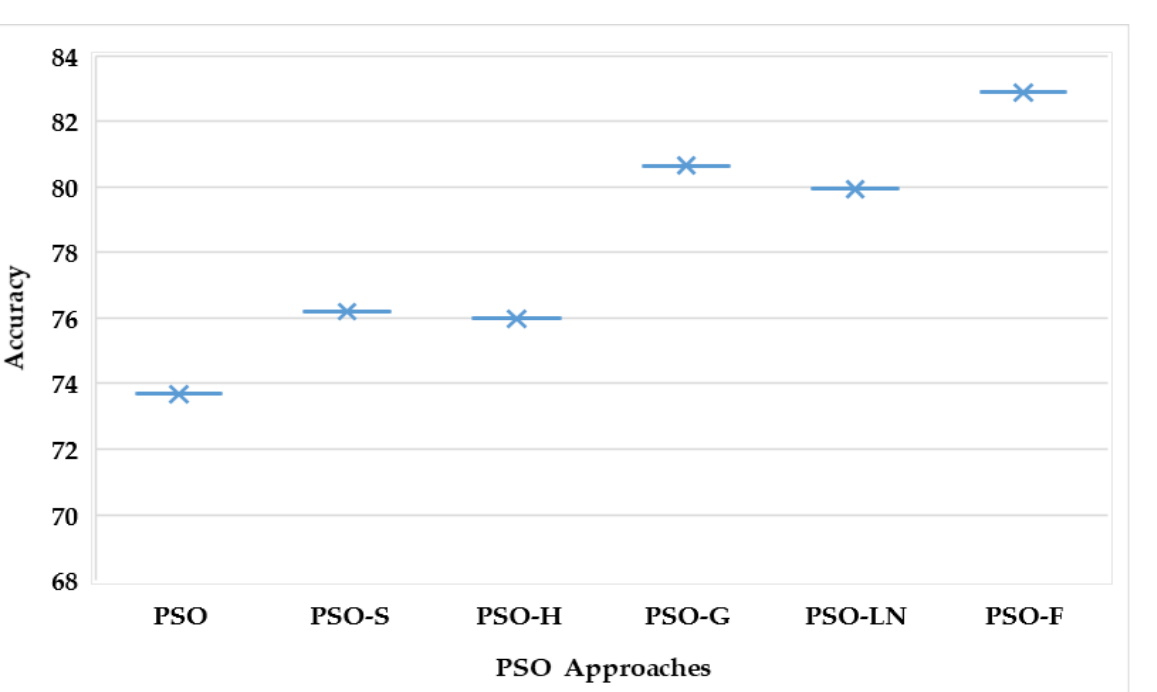
Figure 11. Testing accuracy result of QRS with opposition-based PSO approaches. Iris Wheat seed